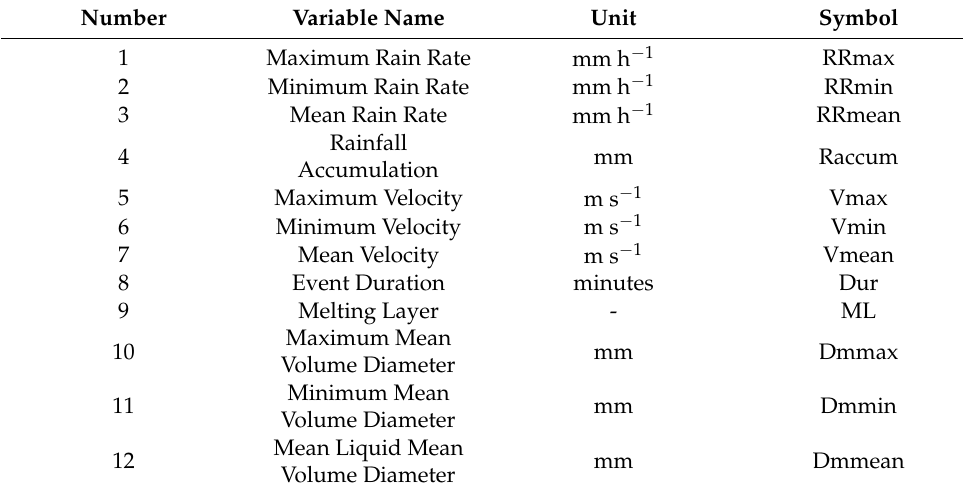
Table 1. Features selected for the cluster analysis.